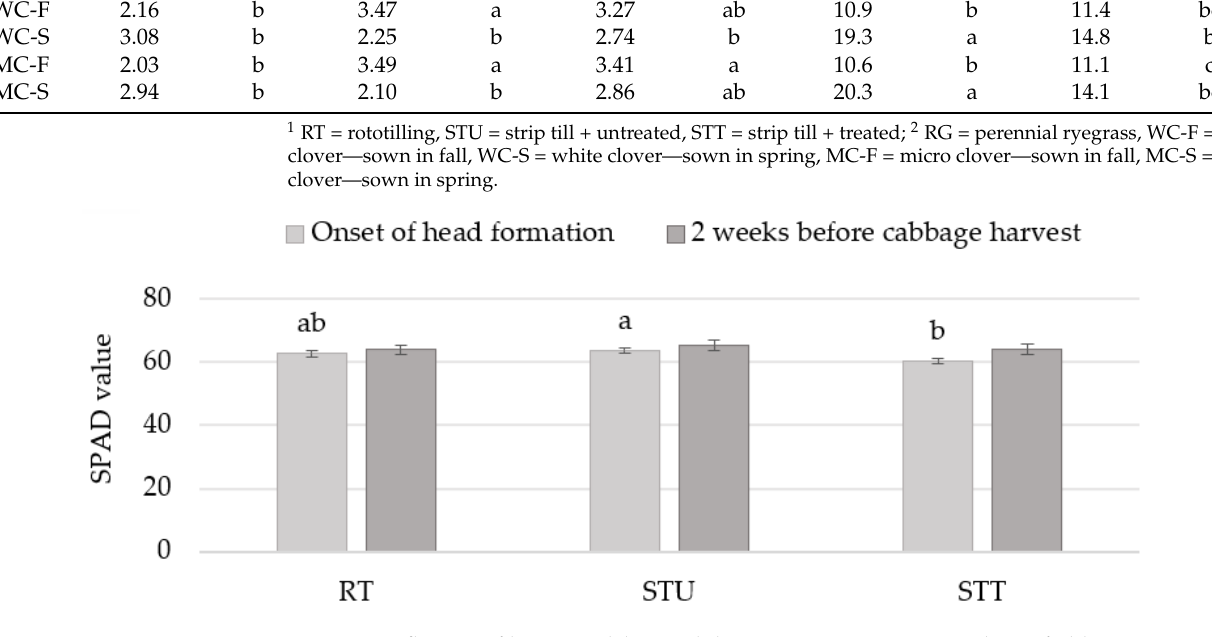
Figure 3. Influence of living mulches and their treatment on SPAD values of oldest, non-senescent leaves of cabbage at the time of head formation onset and two weeks before harvest at both locations. Values with at least one identical letter indicate non-significant differences among LM treatments at α = 0.05. Values without letters were not found to be significantly different indicated via global F test. RT = rototilling, STU = strip till + untreated, STT = strip till + treated.